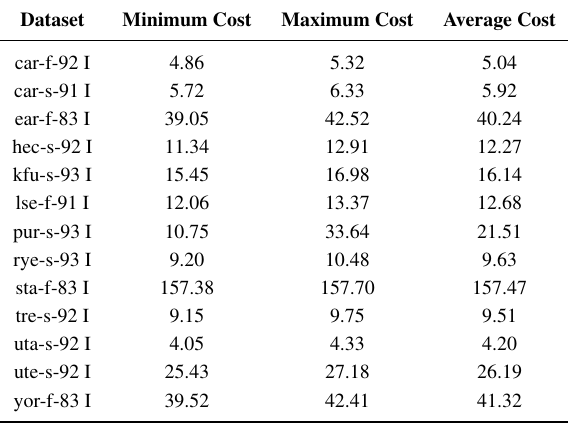
Table 8. Minimum, maximum and average cost with a population size of 256. Dataset Minimum